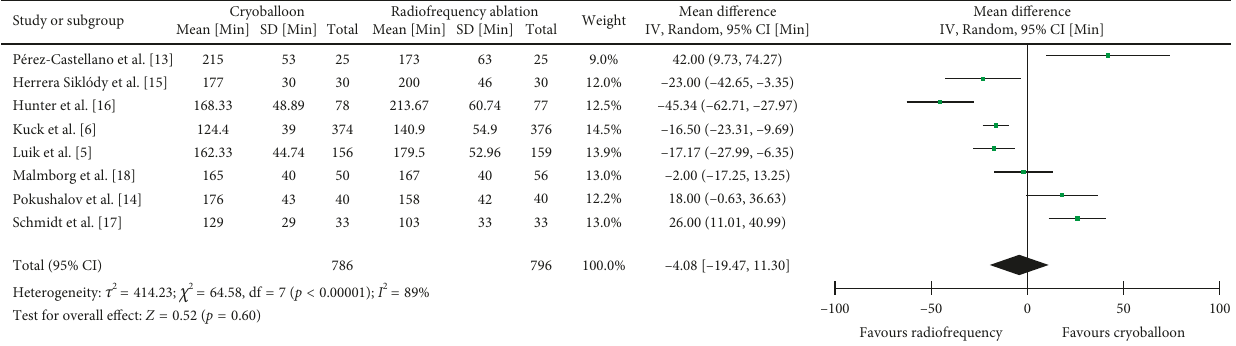
Figure 6: Mean procedure time in minutes with 95% CI of patients receiving cryoballoon versus radiofrequency